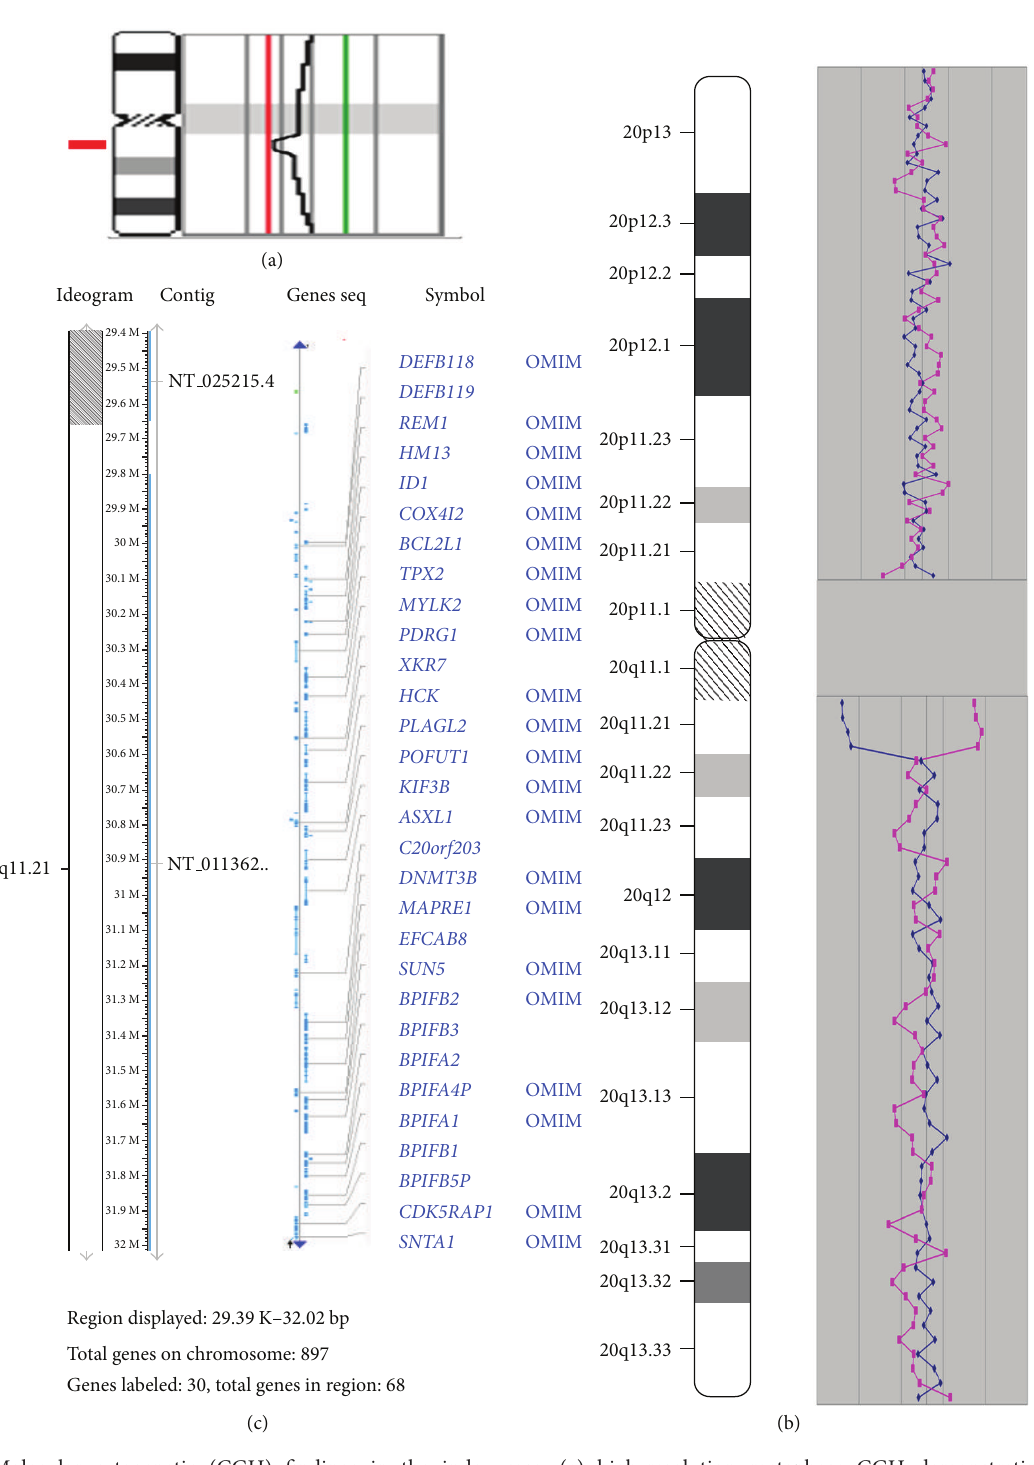
Figure 1: Molecular cytogenetic (CGH) findings in the index case: (a) high-resolution metaphase CGH demonstrating ish cgh dim(20)(q11.21q11.21); (b) array CGH demonstrating arr 20q11.21(29,392,835-32,017,043)x1 (two alternative arrays Cy3/Cy5 (pink line) and Cy5/Cy3 (blue line) were plotted on the graph); (c) and depiction of the deleted chromosomal region by NCBI Build 37.1/NCBI Map